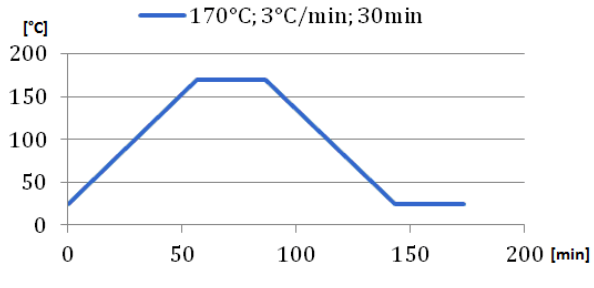
Fig. 3. Plot of testing profile 1.